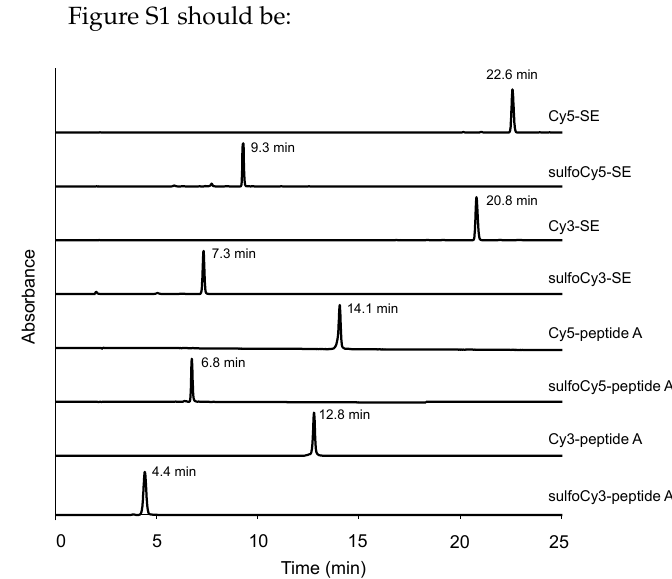
Figure 8. Stability of dye-peptide A in mice plasma. ( a ) 1 μ M Cy5-peptide A and ( b ) 1 μ M sulfoCy5- peptide A were dissolved in the plasma. The plasma containing dye-peptide A was incubated at 37 °C for 1 min or 10 min. 12. Change the supplementary information